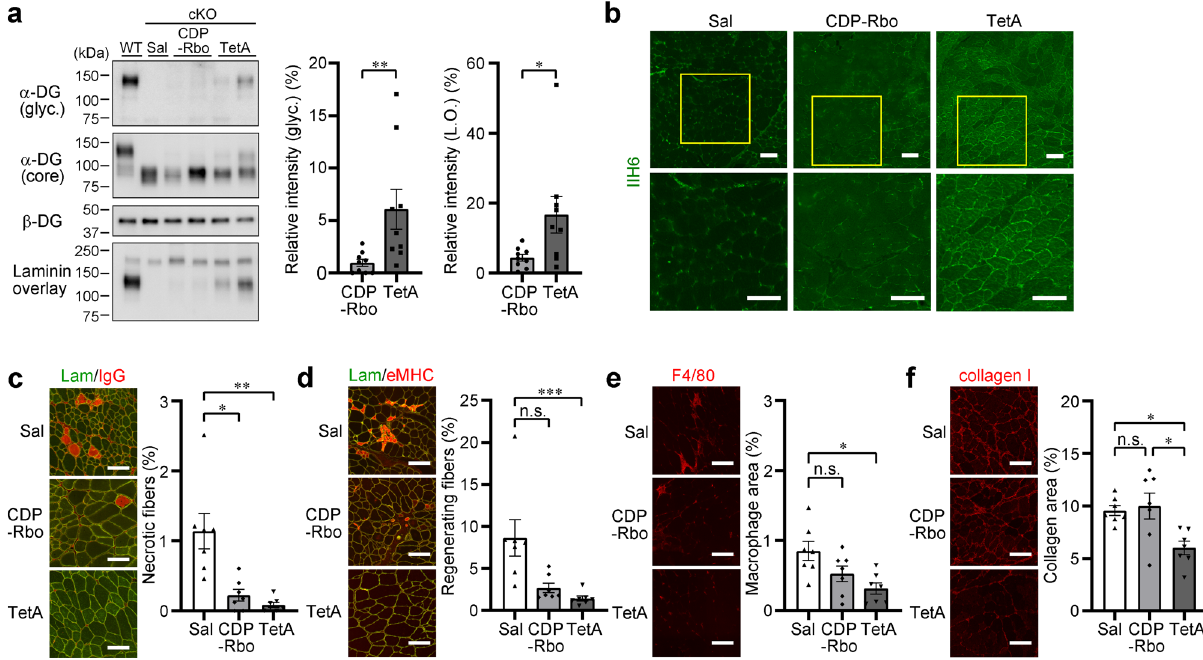
Fig. 5 CDP-Rbo prodrug administration ameliorates the dystrophic pathology of Myf5- Ispd -cKO mice. The TA muscle of 4-week-old mice was injected with CDP-Rbo or CDP-Rbo(TetA) twice weekly (six times in total). Ten days after the fi nal injection, muscles were harvested and subjected to biochemical and histopathological analyses. Saline-treated muscles were used as controls (Sal). a α -DG glycosylation was measured using western blot and laminin overlay analyses after CDP-Rbo or CDP-Rbo(TetA) administration. Right: relative matriglycan signal intensity (ratio of glyc./ β -DG) and laminin-binding activity (ratio of laminin binding/ β -DG) compared to those in WT muscle. Data were analyzed using the Mann-Whitney U test ( p = 0.0039 and 0.024 for IIH6 and laminin overlay respectively, n = 9). b IIH6-immuno fl uorescence analysis after CDP-Rbo or CDP-Rbo(TetA) administration. Areas indicated by yellow squares are enlarged in the lower panels. The images are representative of at least seven mice analyzed in each group. c – f Immuno fl uorescence and quantitative analysis of necrotic fi bers ( c ; p = 0.019, CDP-Rbo vs. Sal, p = 0.001, CDP-Rbo(TetA) vs. Sal), regenerating fi bers ( d ; p = 0.0005, CDP- Rbo(TetA) vs. Sal), macrophage in fi ltration ( e ; p = 0.02, CDP-Rbo(TetA) vs. Sal), and connective tissue area ( f ; p = 0.037, CDP-Rbo(TetA) vs. Sal, p = 0.023, CDP-Rbo(TetA) vs. CDP-Rbo). n = 7 per group. Data represent the mean ± SEM. Data were analyzed using the Kruskal-Wallis ANOVA test followed by Dunn ’ s multiple comparisons. * p < 0.05, ** p < 0.01, and *** p < 0.001. Scale bars, 100 μ m. TA, tibialis anterior. TetA, CDP-Rbo(TetA).